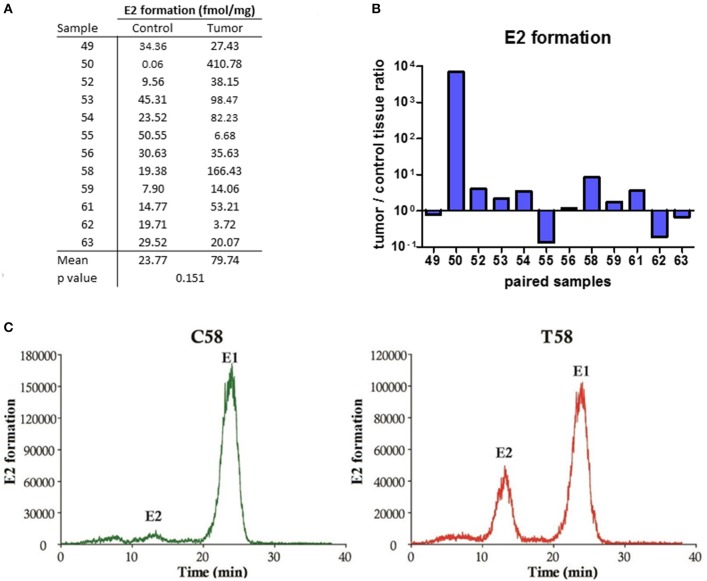
E2 formation in the EC and adjacent control tissues. (A) Table showing the formation of E2 (fmol/mg powdered tissue) in control and corresponding cancer endometrium. (B) Histogram with logarithmic scale demonstrates increased tumor/ control tissue ratio for E2 in 7 of 12 paired samples. (C) HPLC elution profile shows the formation of E2 from E1 for representative control (C58) and cancer (T58) tissues.